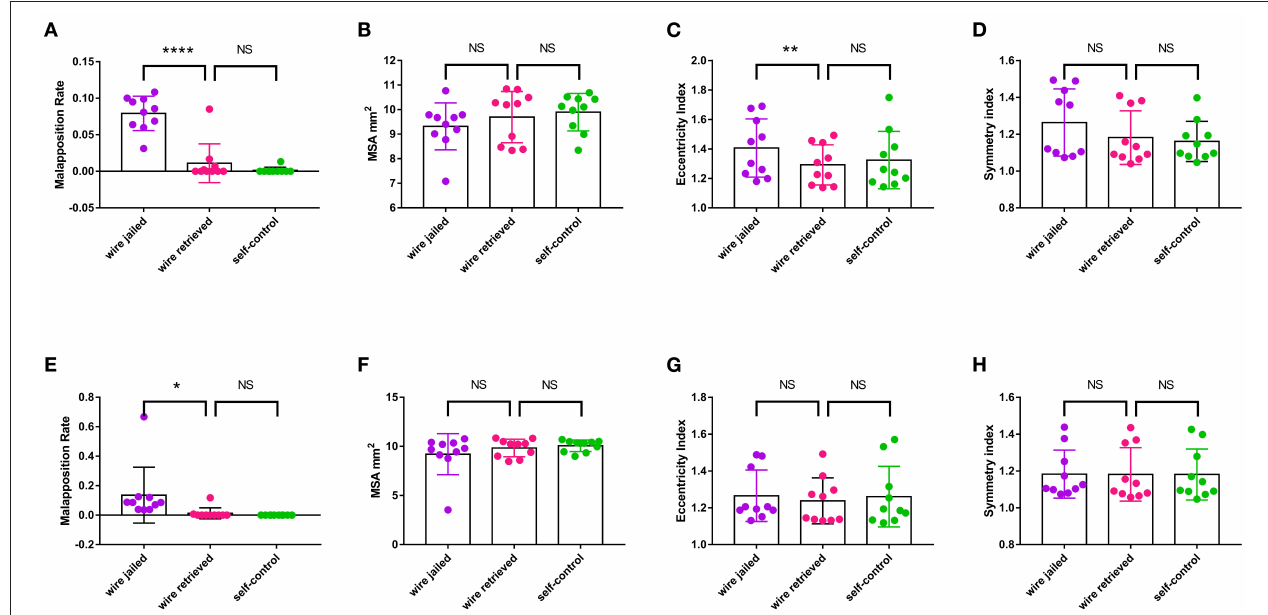
FIGURE 6 | Effect of JB-POT procedures on stent deployment parameters determined by OCT. (A–D) Malapposition rate, MSA, eccentricity and symmetry of the whole stent. (E–H) Malapposition rate, MSA, eccentricity and symmetry of the 2mm stent segment adjacent to SB take-off. MSA, minimum stent area. NS, no significant. * p < 0.1. ** p < 0.05, **** p < 0.0001. n =